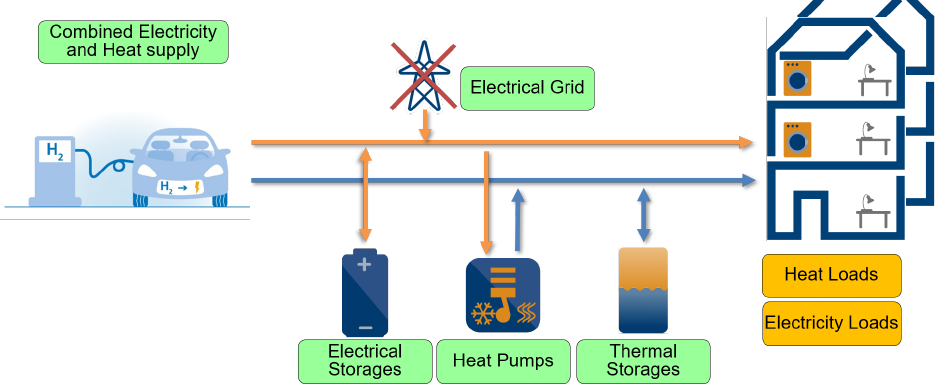
Figure 2. Representation of the relevant model elements: fixed load profiles (orange boxes) and variable power flows to be determined (green boxes). The optimal capacity of the electrical and thermal storage capacity is also to be determined by the solver. As a period with low renewable energy being available is considered, no electricity is available from the grid. The model should therefore avoid the draw of electrical power from the